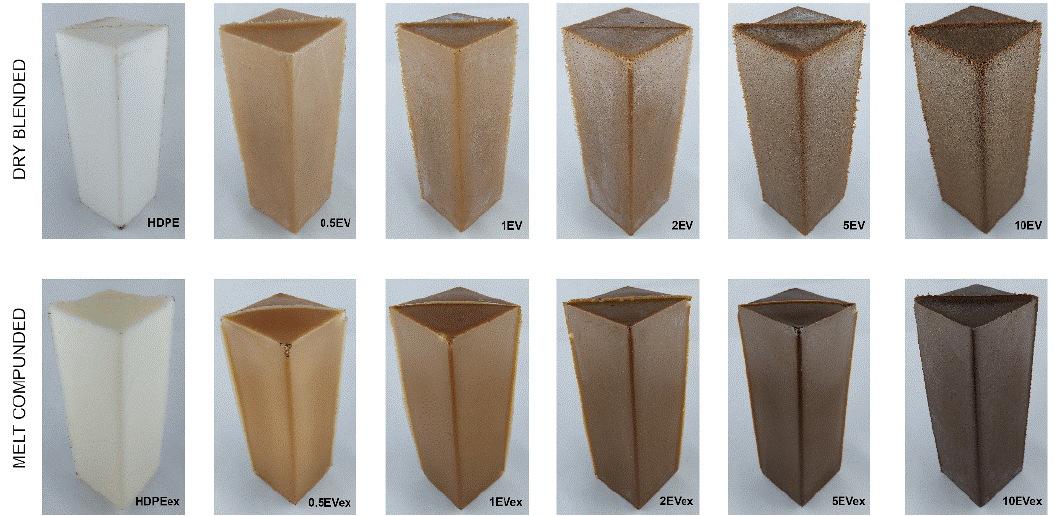
Figure 1. Rotomolded composites with expanded vermiculite.